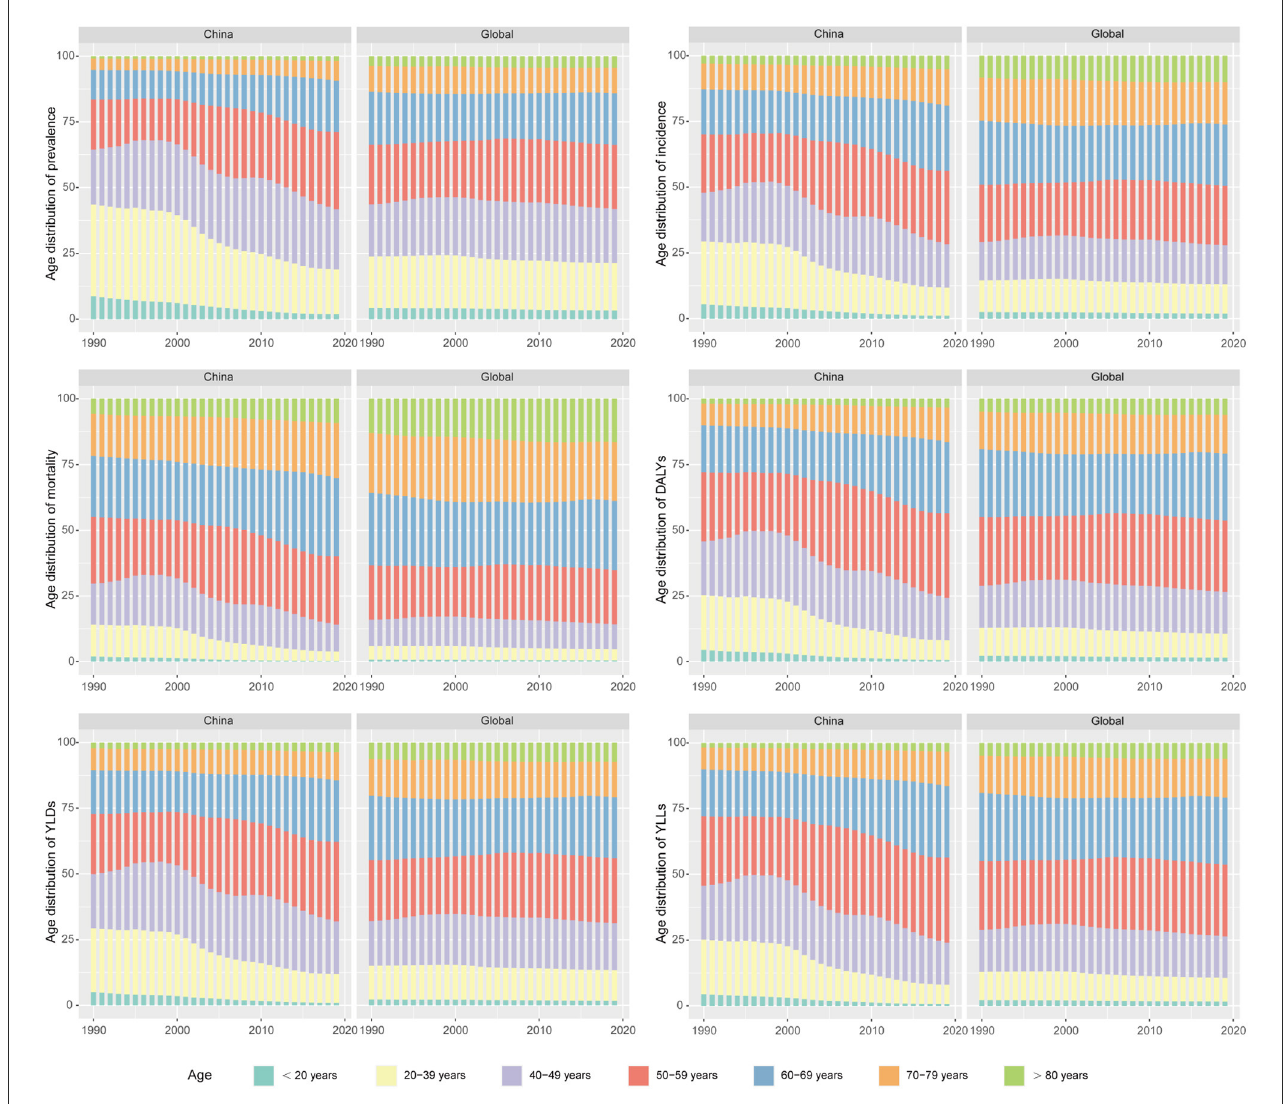
FIGURE3 The trends in age distribution of ovarian cancer burden in China and the global level from 1990 to